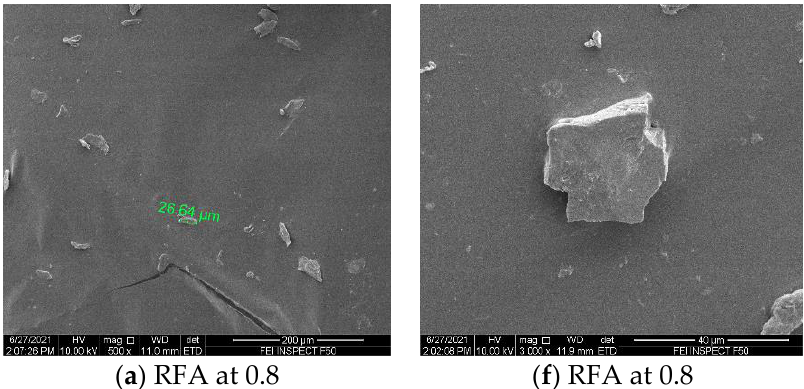
Figure 12. Nanoindentation modulus of asphalt mastic specimens. (As can be seen from the un- derlined data, the nanoindentation modulus of the RFA 1.6 was approximately twice the modulus of RFA 1.2)